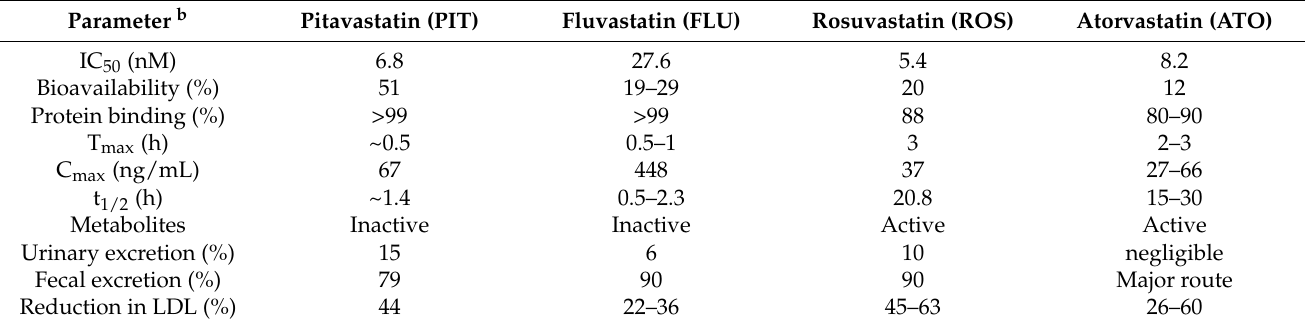
Table 2. Comparative clinical efficacies and pharmacokinetics and of the investigated statins a